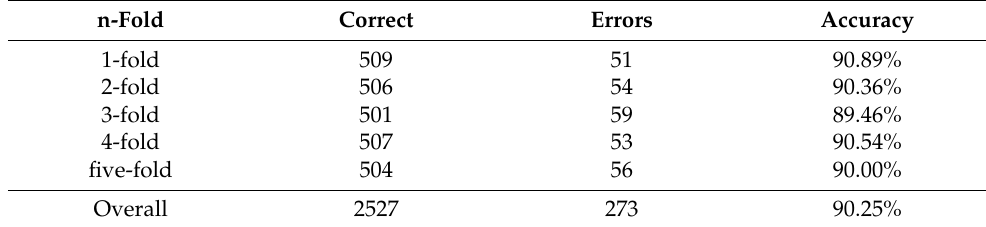
Table 3. The results per fold of the facial gesture recognition